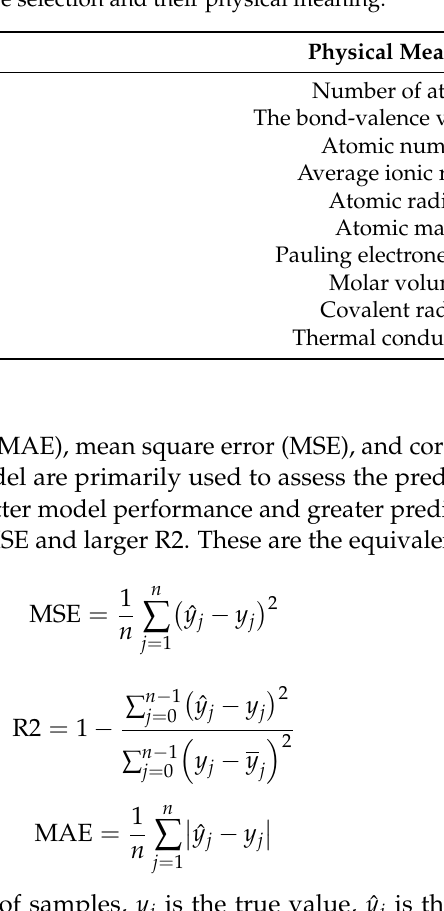
Table 2. Descriptor set after feature selection and their physical